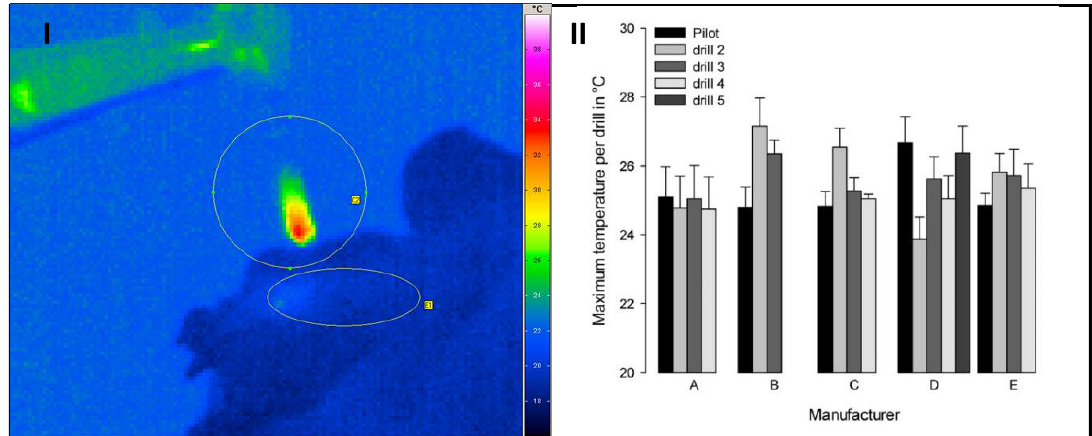
Figure 6. Thermogram after drilling with temperature distribution at the tip of the drill (circle) and at the entrance of the drilled hole (ellipse) ( I ). Maximum temperature with the different tools of five commercial drill sets measured at the tip of the drill ( II ) (mean ± SEM; n = 4).